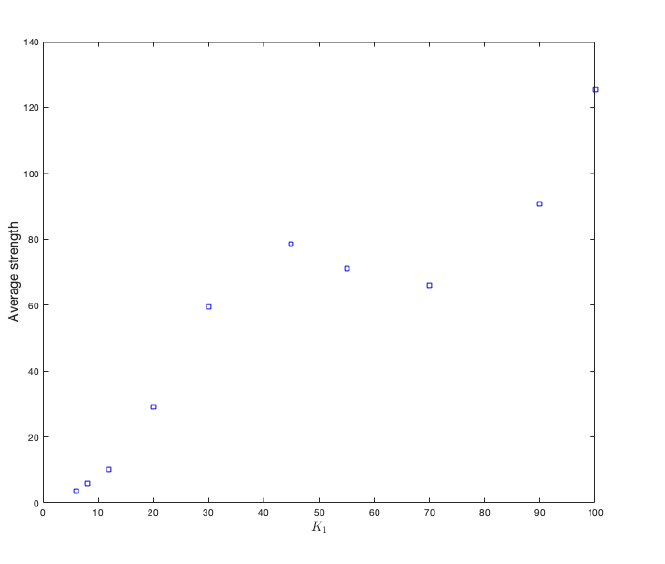
Figure 10. Average strength of vertices for each value of K 1 .